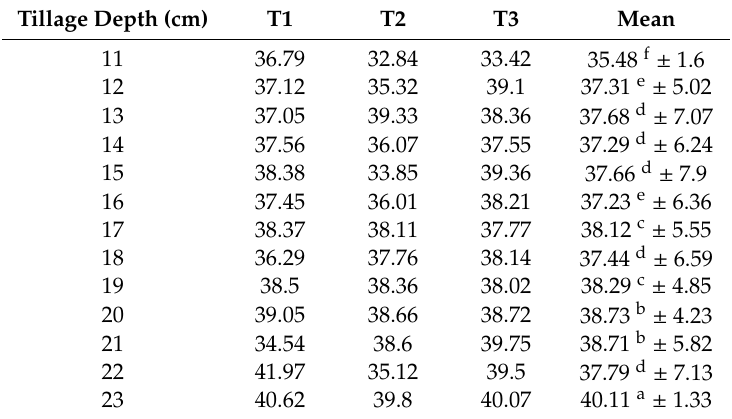
Figure 10. Overall mean power requirements of the engine according to tillage depth. Table 6. Descriptive statistics of engine power requirements (kW) according to tillage